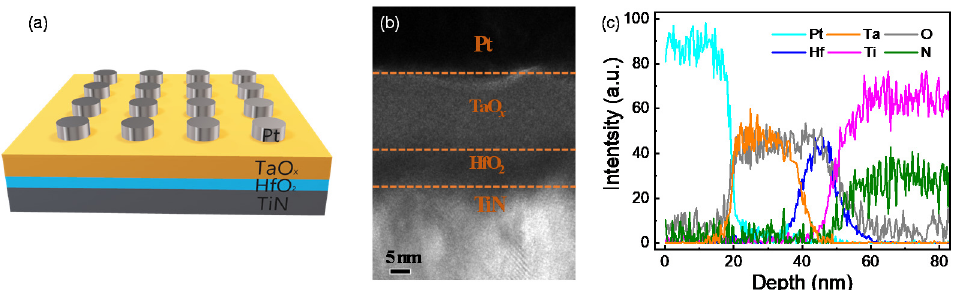
Figure 1. Device configuration of Pt/TaO x /HfO 2 /TiN capacitor structure: ( a ) Schematic; ( b ) TEM image; ( c ) EDS line scan.